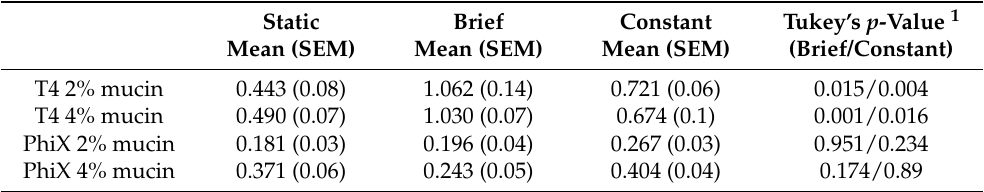
Table 6. Means of phage containing 2% and 4% mucin samples at MOI